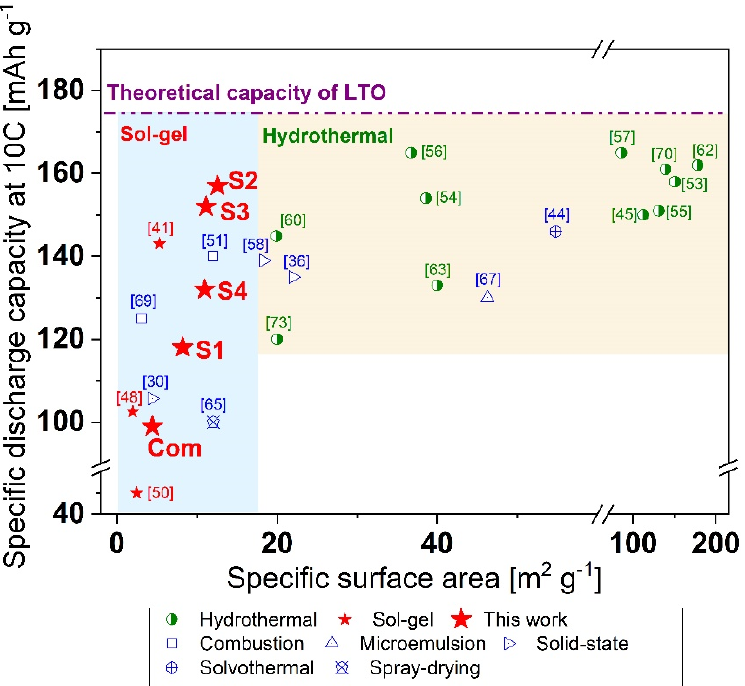
Figure 7. Comparison between high rate performance as a function of the surface area in LTO produced via different synthetic methods [30,36,41,44–46,48,50,51,53–58,62–64,67,69,70,73].